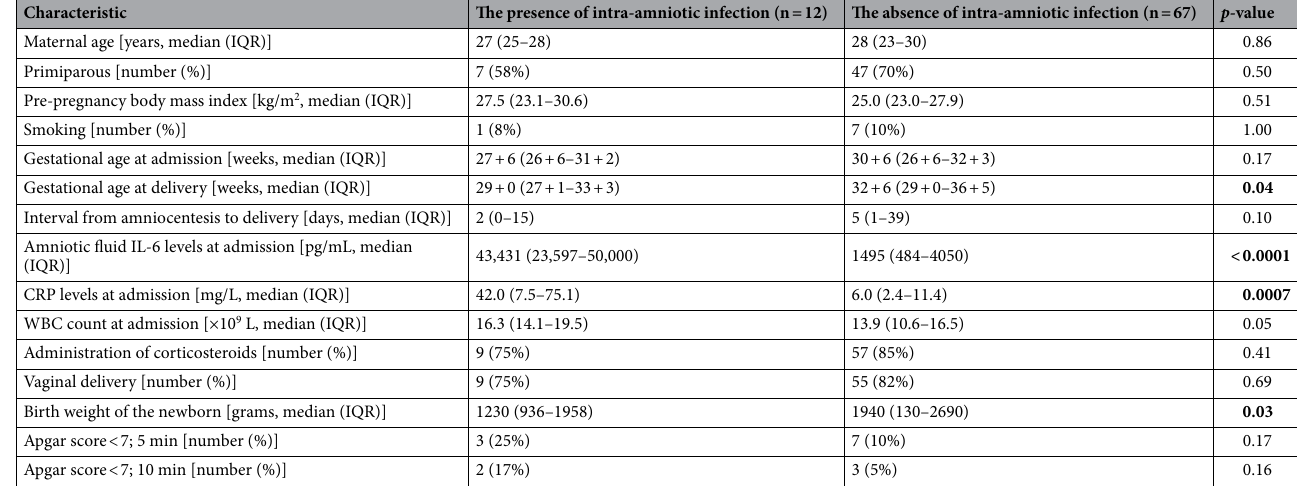
Table 2. Maternal and clinical characteristics of women with spontaneous preterm labor with intact membranes based on the presence and absence of intra-amniotic infection. Continuous variables were compared using a nonparametric Mann–Whitney U test. Categorical variables were compared using the Fisher’s exact test. Continuous variables are presented as median (IQR) and categorical as number (%). Statistically significant results are marked in bold. RP: C-reactive protein; IL: interleukin; IQR: interquartile range; WBC: white blood cells.